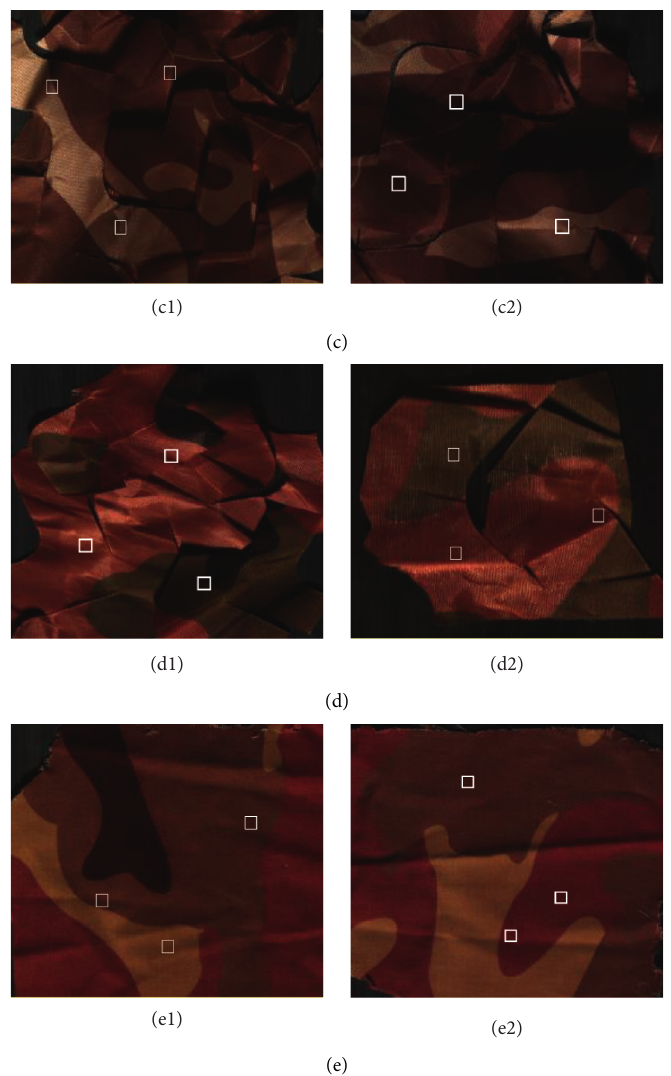
Figure 5: Part of the results of the ROI. (a) Part of the results of ROI in desert background. (b) Part of the results of ROI in jungle background. (c) Part of the results of ROI in desert camouflage netting. (d) Part of the results of ROI in jungle camouflage netting. (e) Part of the results of ROI in jungle camouflage